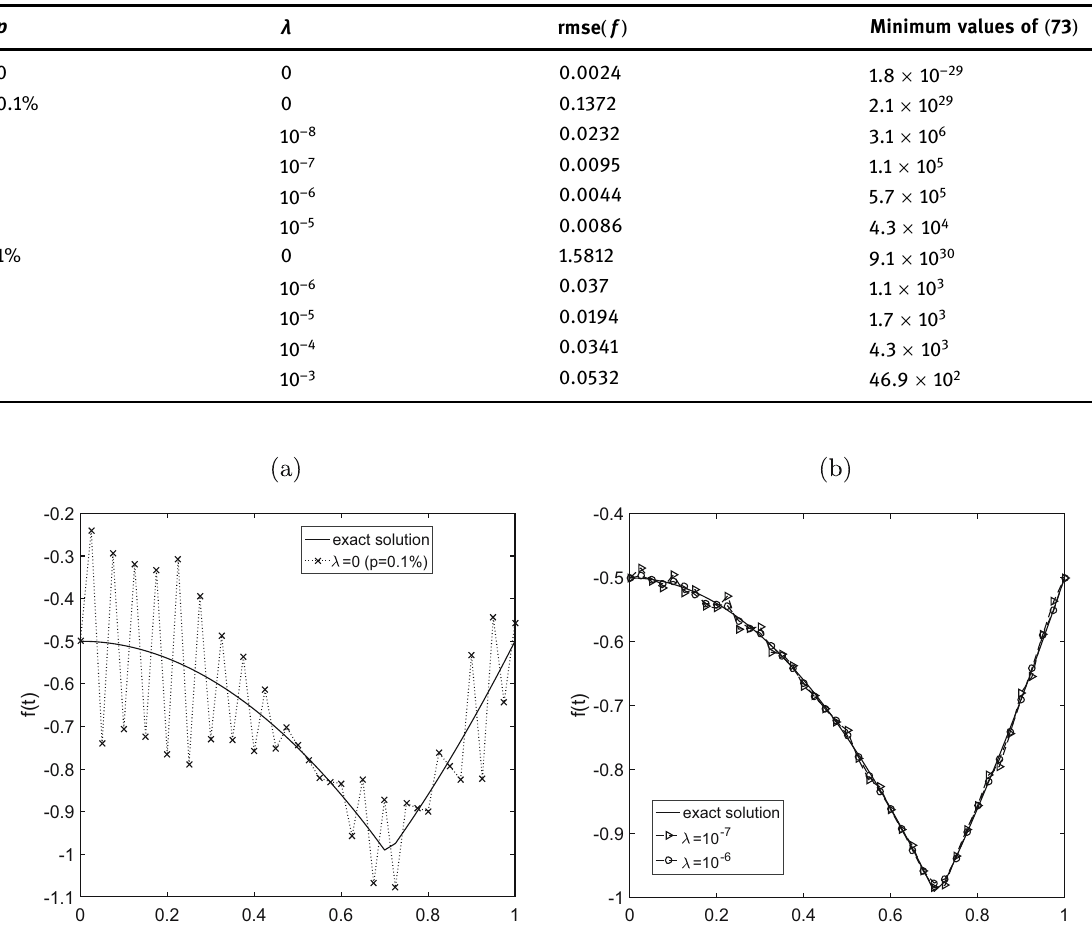
Table 4: The rmse and the least value of ( 73 ) for